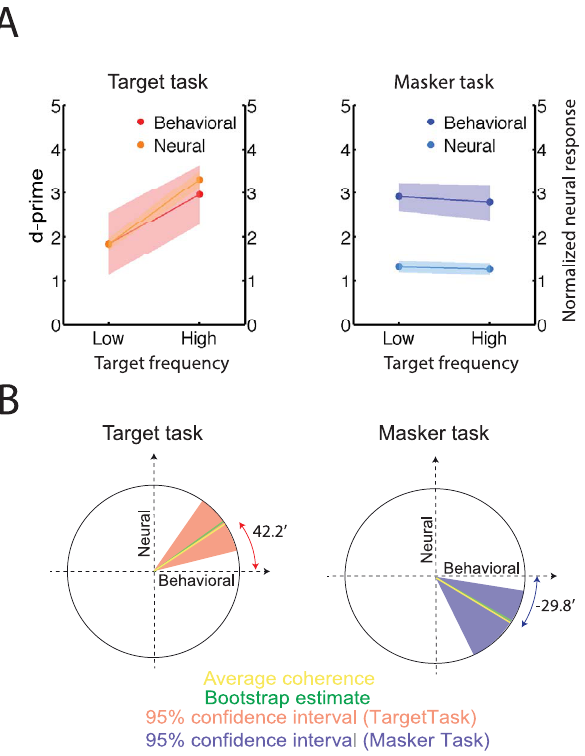
Fig. 5. Bottom-up saliency of the target sequence increases for higher target frequencies. (A) Behavioral and neural responses (MEG experiment C, N 5 12) as a function of target frequency. In the left panel, the red/orange line corresponds to behavioral and neural responses for the target task with respect to the low and high target frequency. In the left panel dark/light blue corresponds to behavioral and neural responses for the masker task. Error hull represent 1 SEM. (B) Correlation of the behavioral and neural responses as a function of target frequency. The ratio of the neural to behavioral response differences as a function of target frequency is averaged across participants. A mean slope angle of 42.4 ˚ for target (left plot) task and 2 29.8 ˚ for masker (right plot) task (yellow line) were obtained in this analysis. As detailed in Methods, the slope angle corresponds to the strength of correlation between neural and behavioral data. Bootstrap estimates (overlying green lines) and their 95% confidence intervals (pink and blue background for the target and masker task, respectively) confirm the positive/negative correlations for target/masker